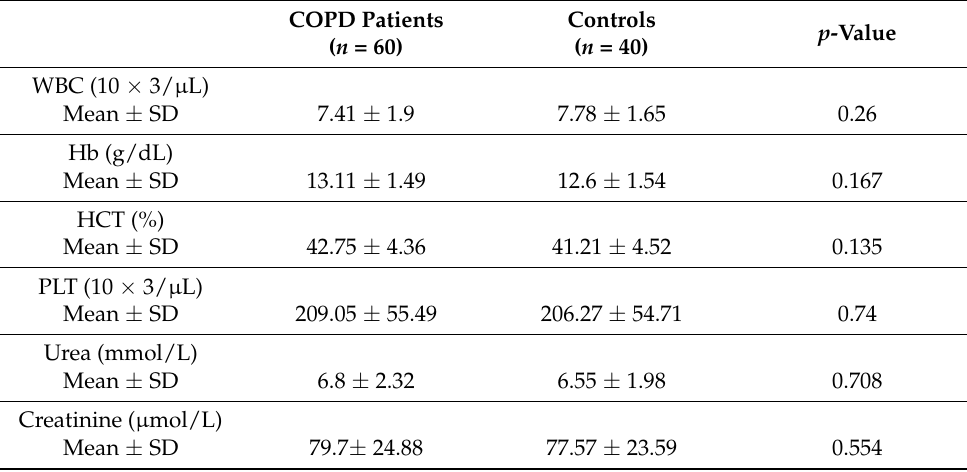
Table 2. Laboratory parameters of COPD patients and